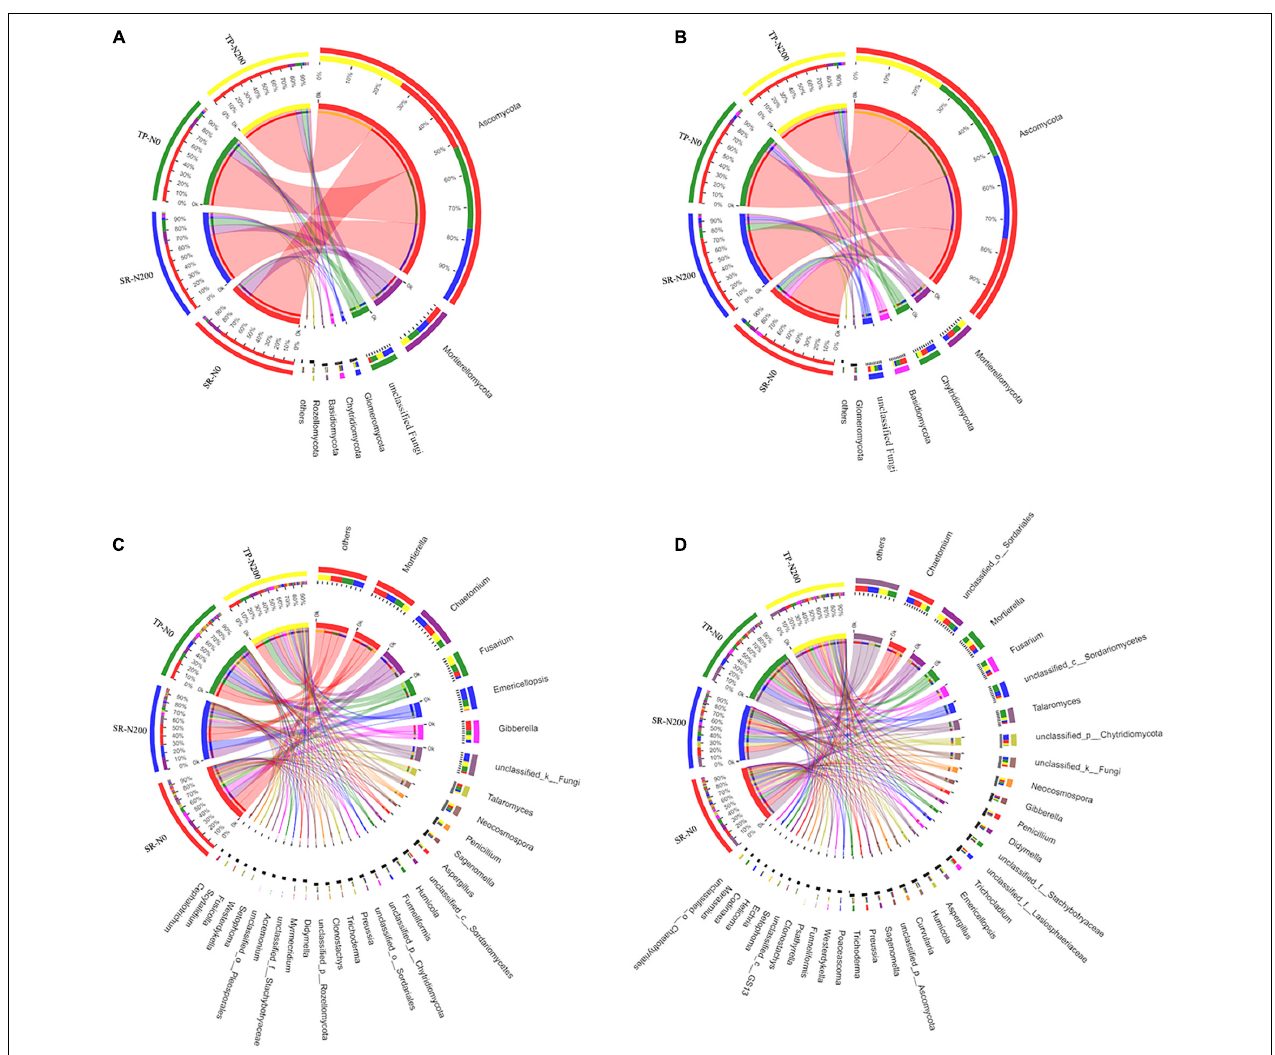
FIGURE 4 | Relative abundances of fungal in spring (A) and autumn (B) communities at the phylum level, and abundance at the genes level in spring (C) and autumn (D) seasons. SR-N0 = straw returning without N fertilizer application; SR-N200 = straw returning with 200 kg ha − 1 N fertilizer application; TP-N0 = traditional planting without N fertilizer application; TP-N200 = traditional planting with 200 kg/ha nitrogen fertilizer